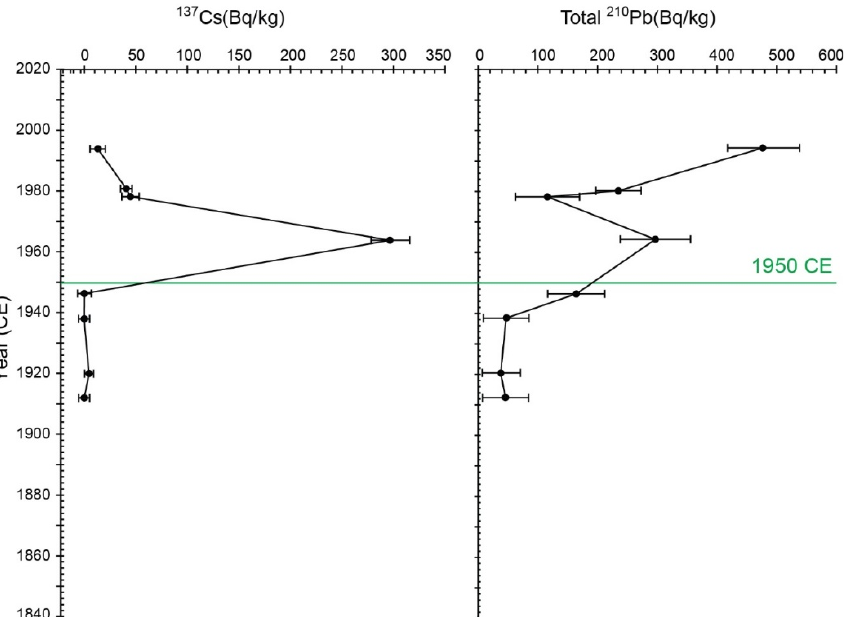
Figure 9. Results of gamma analysis of samples spanning 2 varve years from core CRA22-1FRA-3, archived at the Canadian Museum of Nature with proposed Anthropocene GSSP, 1950 CE, shown as a solid horizontal line (data in Table 1). The peak activity of 137 Cs is consistent with the global peak (1963-64 CE) and limited number of 210 Pb points, which are developed in more detail from the 210 Pb age model in another core (CL-19) from the deep basin of Crawford Lake [30]. Anomalous results obtained from the thick calcite-rich varve deposited in 1980-81 is attributed to the chemistry of the sediments. Table 1. Summary of gamma analysis of bulk sediment sampled along varve boundaries in freeze core CRA22-1FR-3. Grey shading identifies peak in 137 Cs activity, consistent with global peak in 1964 CE. B, Cumming, Queen ’ s U., analyst, using methodology described in McCarthy et al. Adapted with permission from [30] McCarthy et al. in press / 2023.